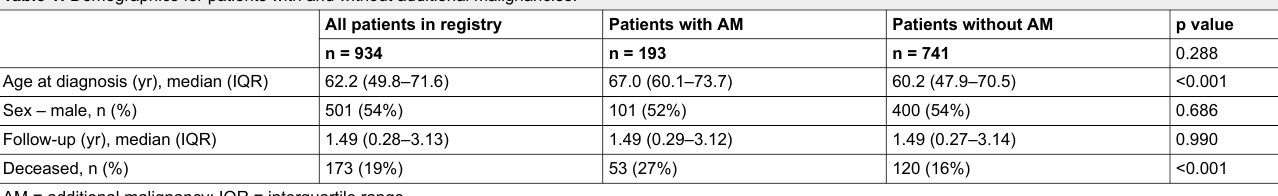
Table 1: Demographics for patients with and without additional